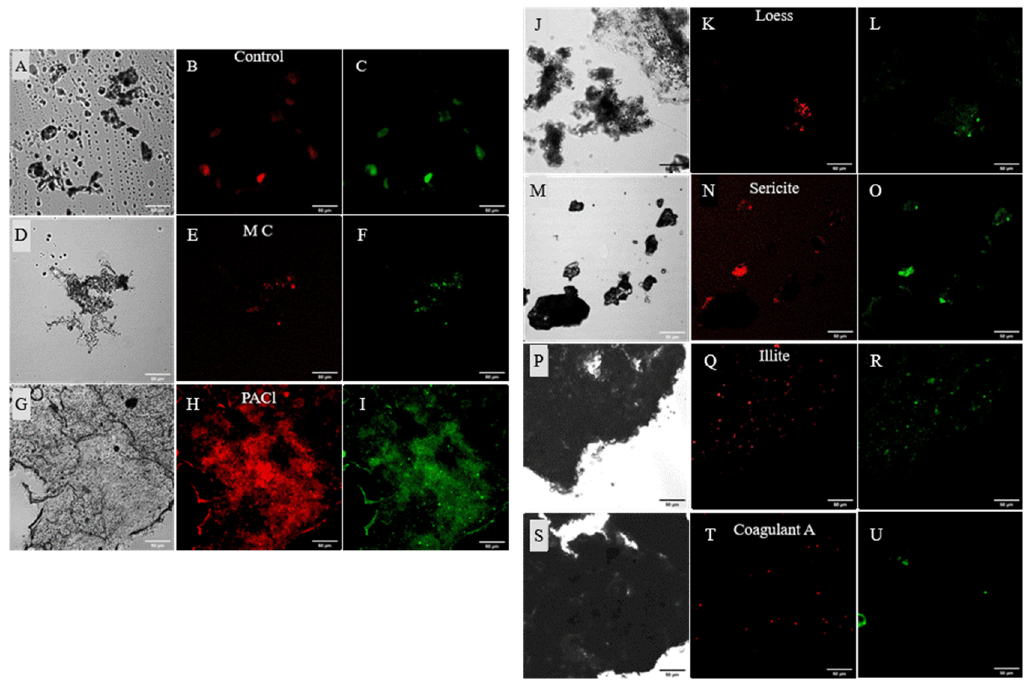
Figure 5. Images of cyanobacterial cells in the control ( A – C ), MC ( D – F ), PACl ( G – I ), Loess ( J – L ), Sericite ( M – O ), Illite ( P – R ), and Coagulant A ( S – U ). Each image of ( A , D , G , J , M , P , S ) shows bright- field, ( B , E , H , K , N , Q , T ) red autofluorescence of cells, and ( C , F , I , L , O , R , U ) SYTOX ® Green staining. Cells with a green fluorescence color show that there is a cell damage indicating that the dye bound to nucleic acid. Scale bar = 50 μ m. MC: mineralized coagulant; PACl: polyaluminum chloride; Coagulant A: commercial coagulant.